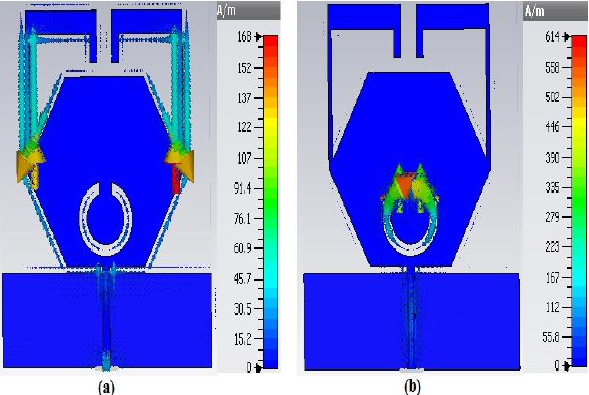
Table 4: Comparison between recently proposed antennas and this